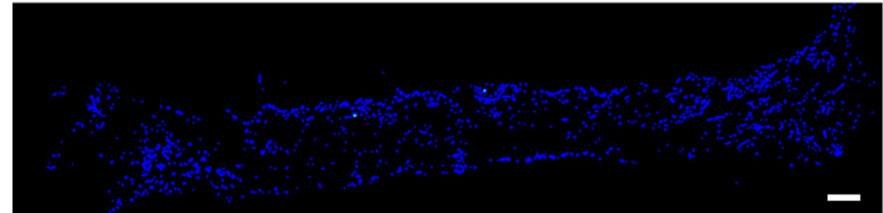
Figure 2. Cells grown on sponges in vitro.The images of rat dedifferentiated adipocytes stained with 4’,6‐diamidino‐2‐phenylindole (DAPI). Bars: 500 μm.